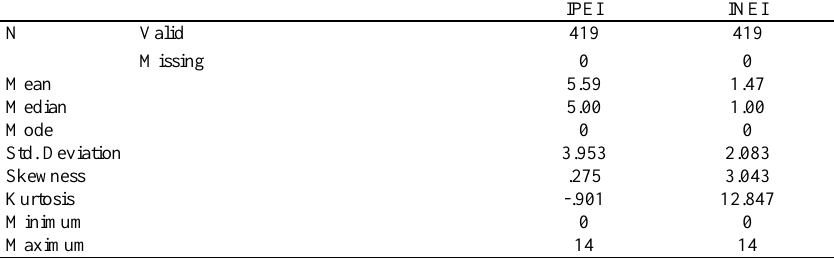
Table 3. The distribution of IPEI and INEI